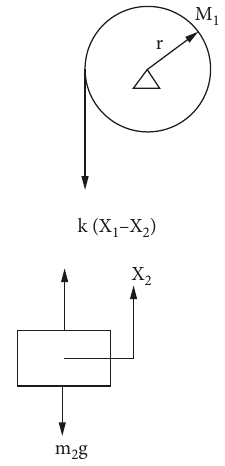
Figure 4: Suspension model of elastic steel wire